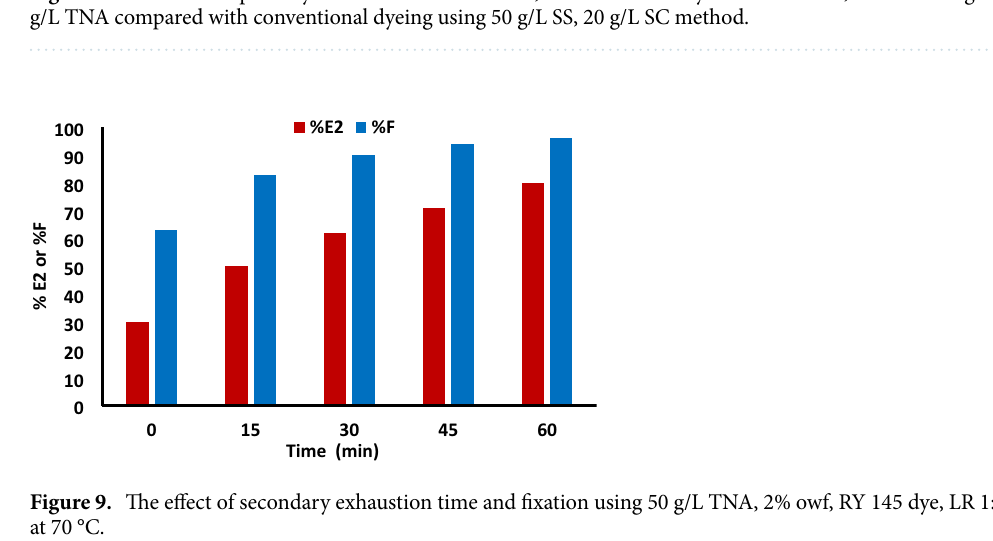
Figure 8. The effect of primary exhaustion time at 40 °C, 2% owf RY 145 dye concentration, LR 1:40 using 50 g/L TNA compared with conventional dyeing using 50 g/L SS, 20 g/L SC method.